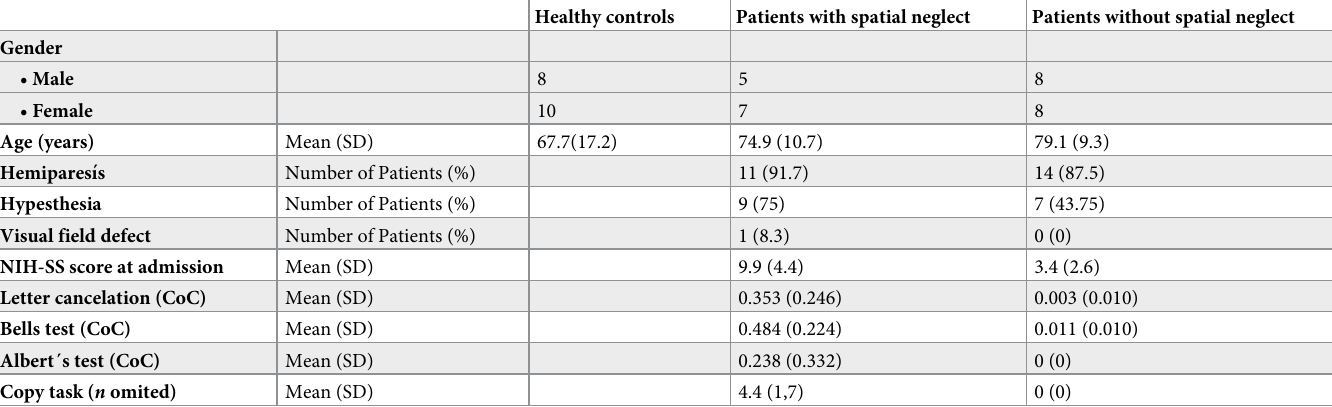
Table 1. Clinical and demographic data of all subjects